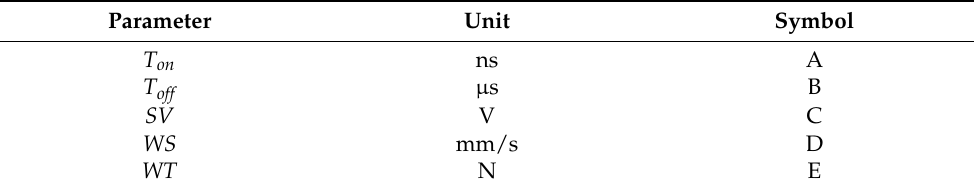
Table 3. Experimental